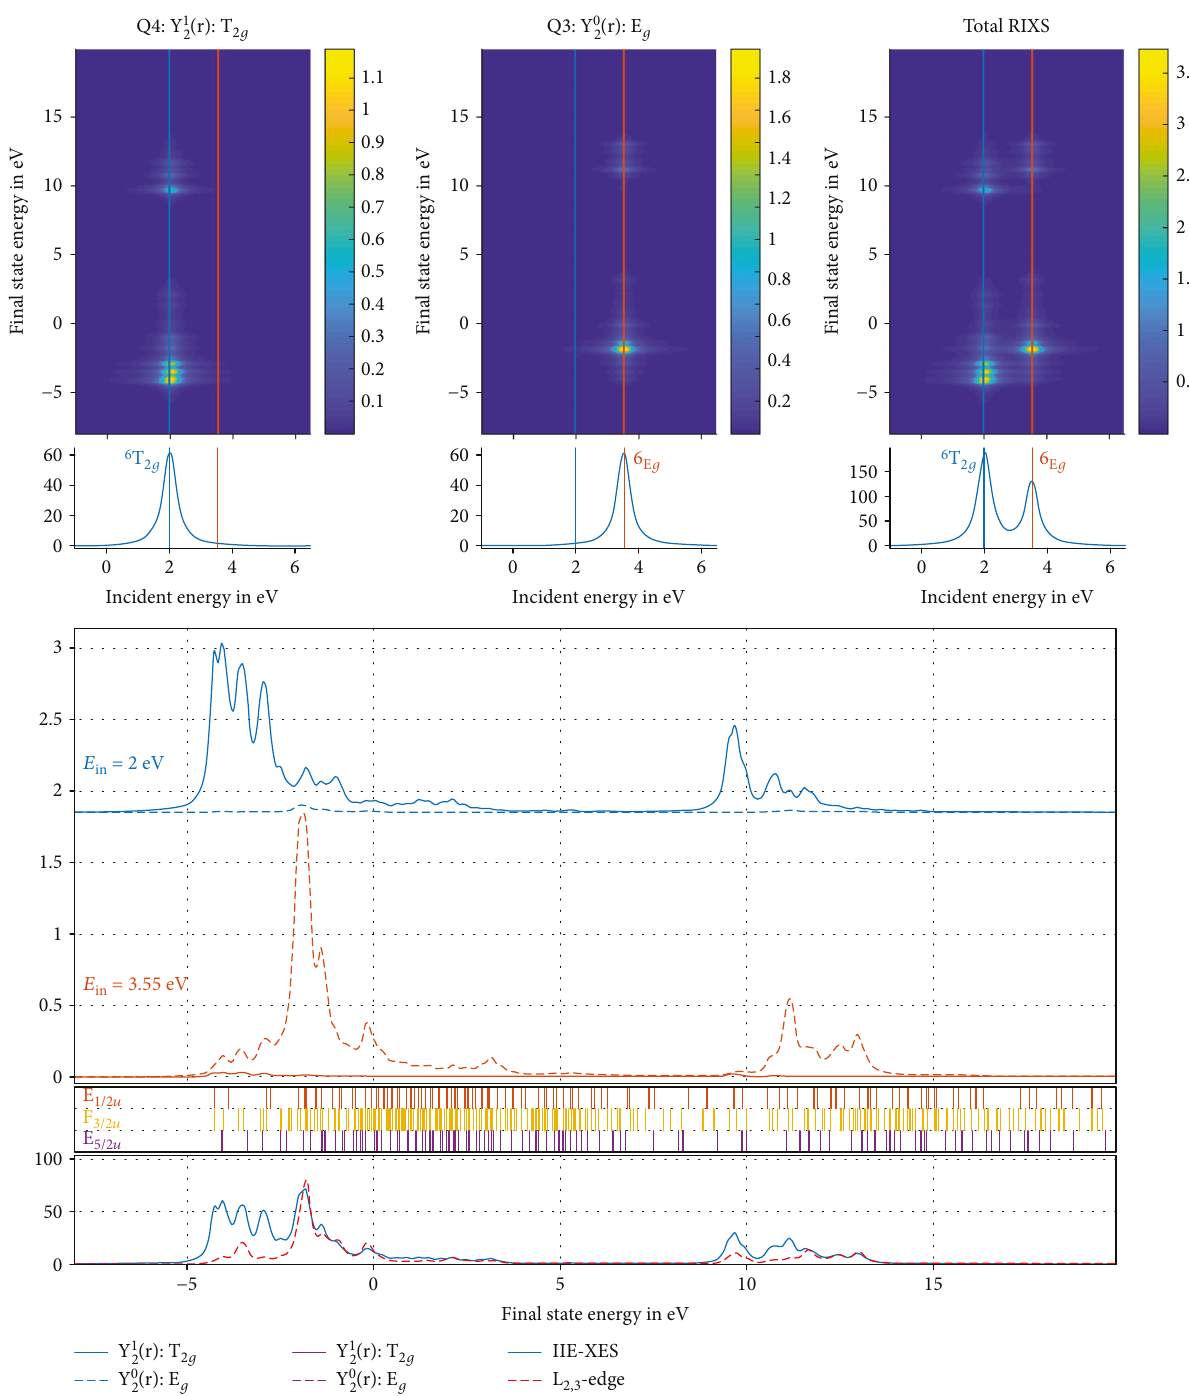
Figure 40: Calculated 1s2p RIXS spectrum for Fe 3+ ( 3d 5 ) for 10D q = 1 5eV (high